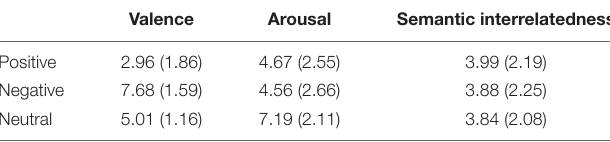
TABLE 2 | Mean (SD) ratings of pictures. TABLE 3 | Self-report ratings of videos from pilot